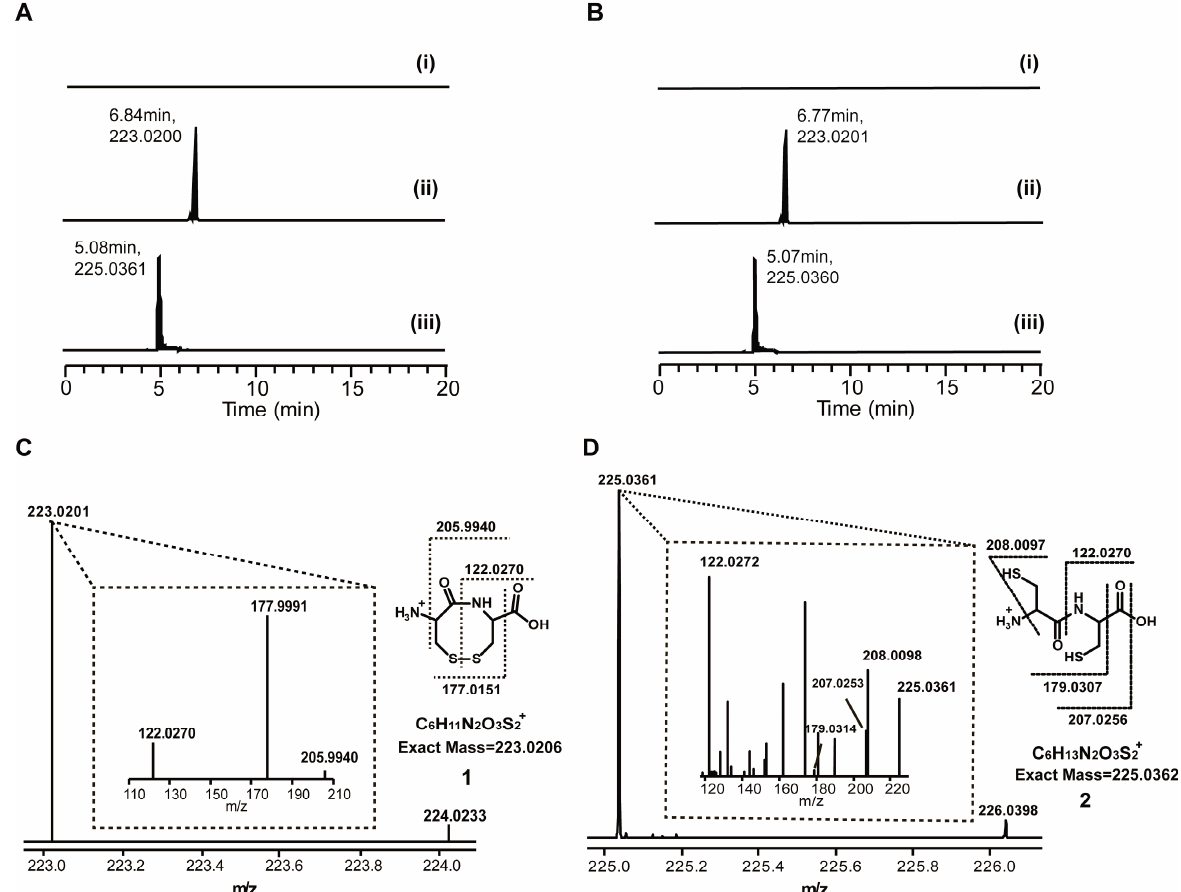
Figure 2. Special bicyclic structure of dithiolopyrrolones and analysis of products from cysteine loading assays with DtpB and DtpB-APCP: ( A ) Molecular weight extraction on MS (mass spectrometry) spectrum of hydrolysis products of DtpB; (i) control without ATP, (ii) reaction assay, (iii) reaction assay with TCEP. ( B ) Molecular weight extraction on MS (mass spectrometry) spectrum of hydrolysis products of and DtpB-APCP. ( C ) MS 2 spectrum of compound 1 . ( D ) MS 2 spectrum of compound 2 .